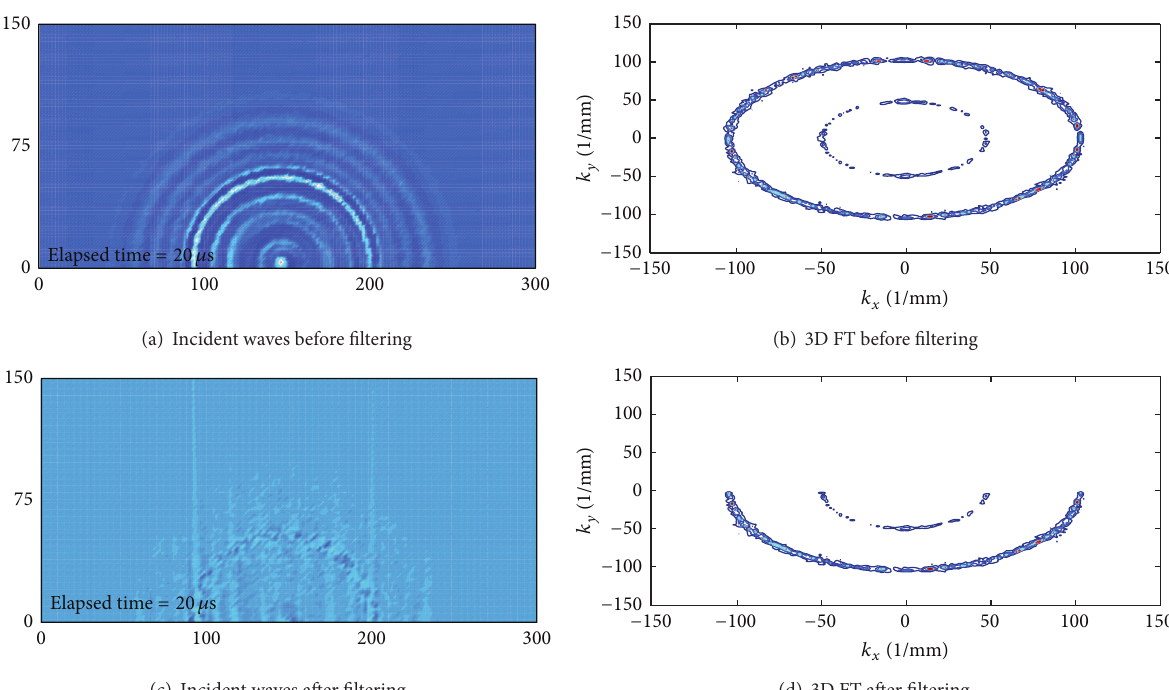
Figure 5: Elimination of upward incident waves by wavenumber